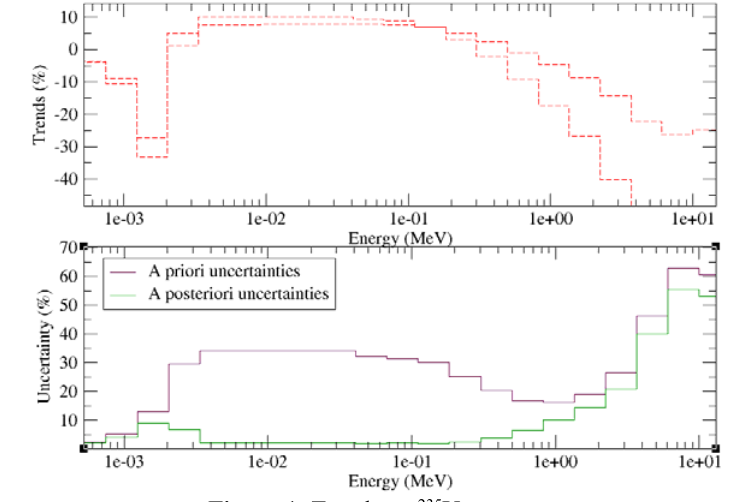
Figure 1 : Trends on 235 U